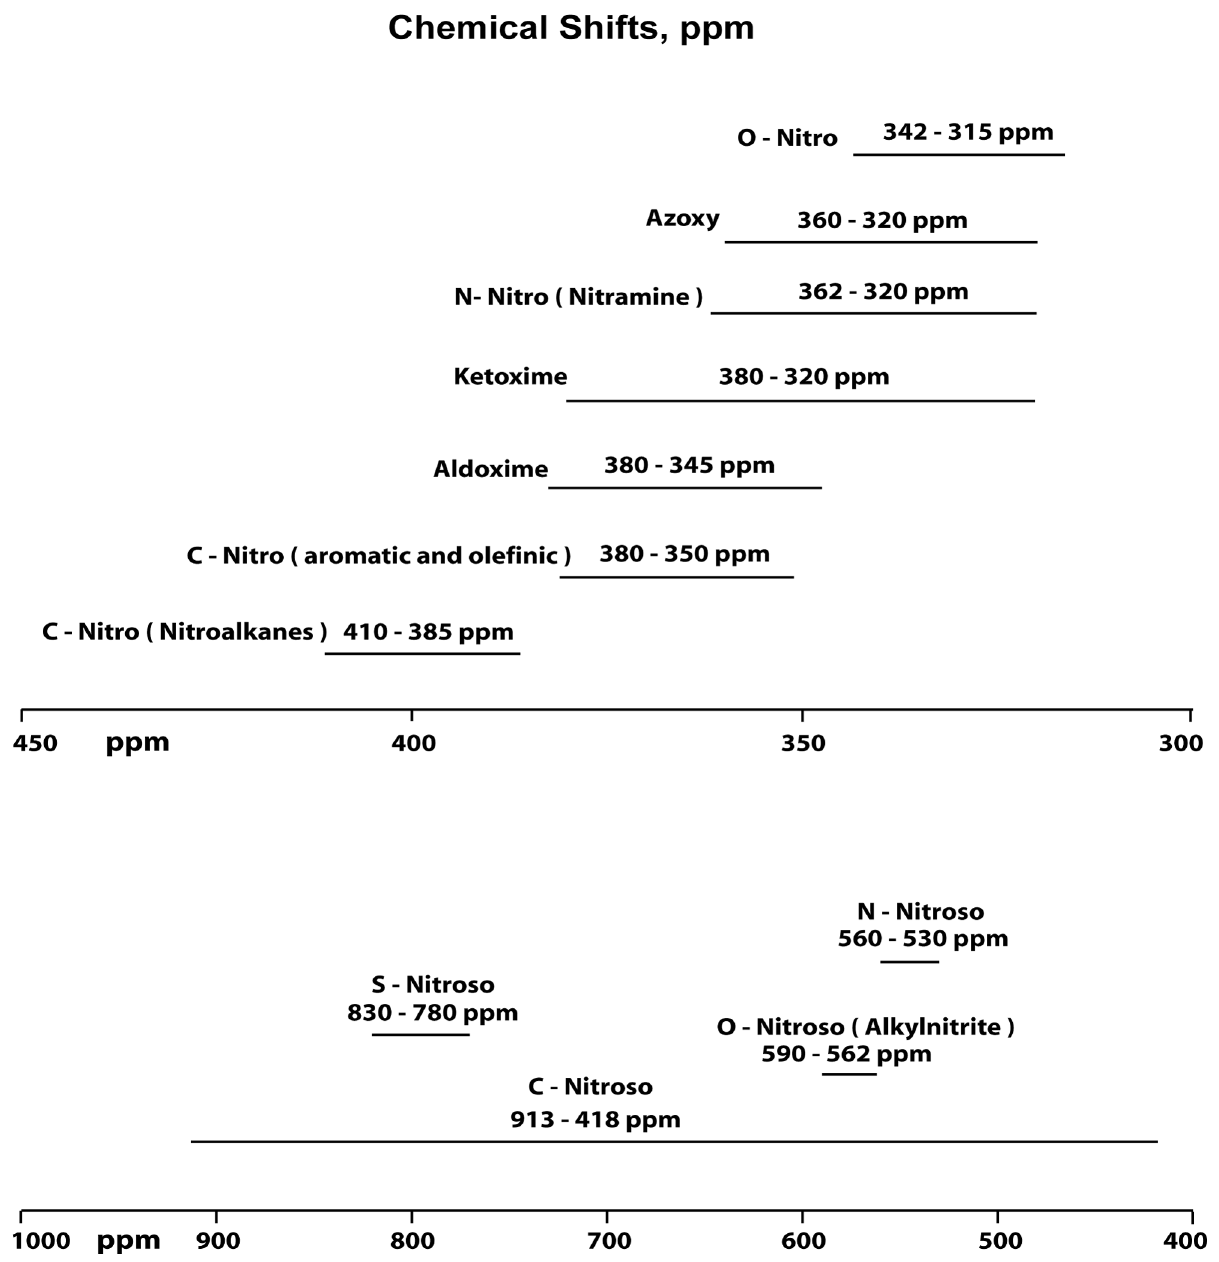
Fig 3. Nitrogen-15 NMR chemical shift ranges for oxime, nitro, and nitroso nitrogens on the ammonia scale. Reproduced from ref. [6].